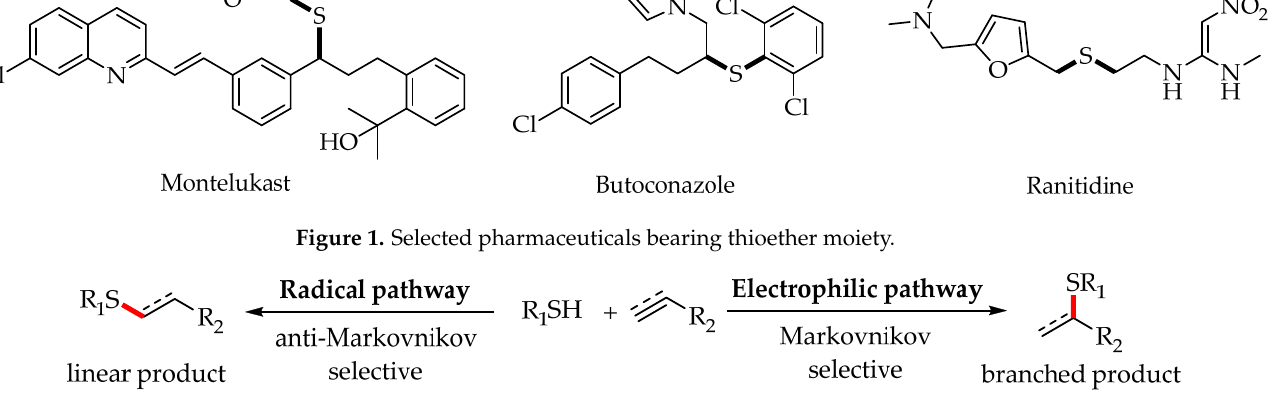
Scheme 1. The general reaction pathway for the thiol ‐ ene/yne reactions.